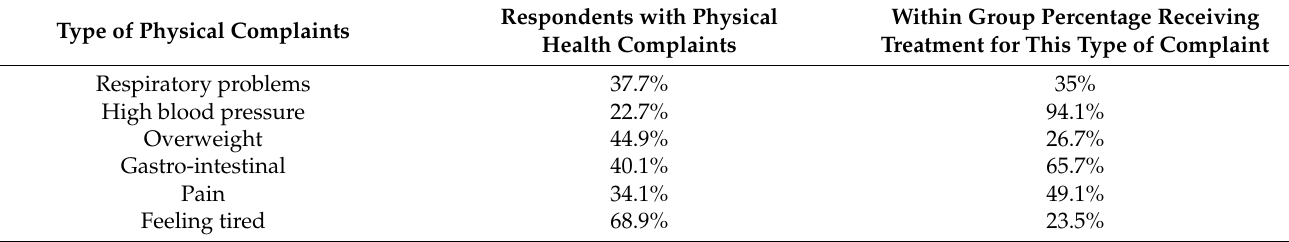
Table 3. Prevalence of physical health complaints among